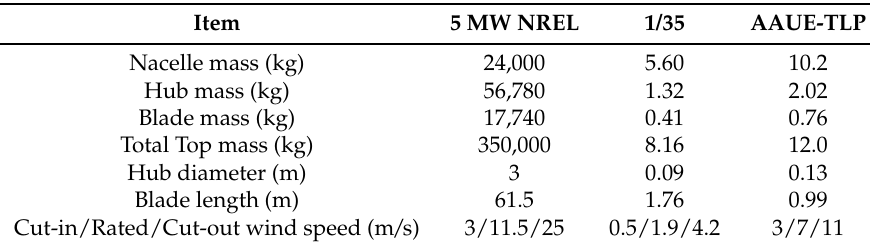
Table 1. Nacelle and rotor